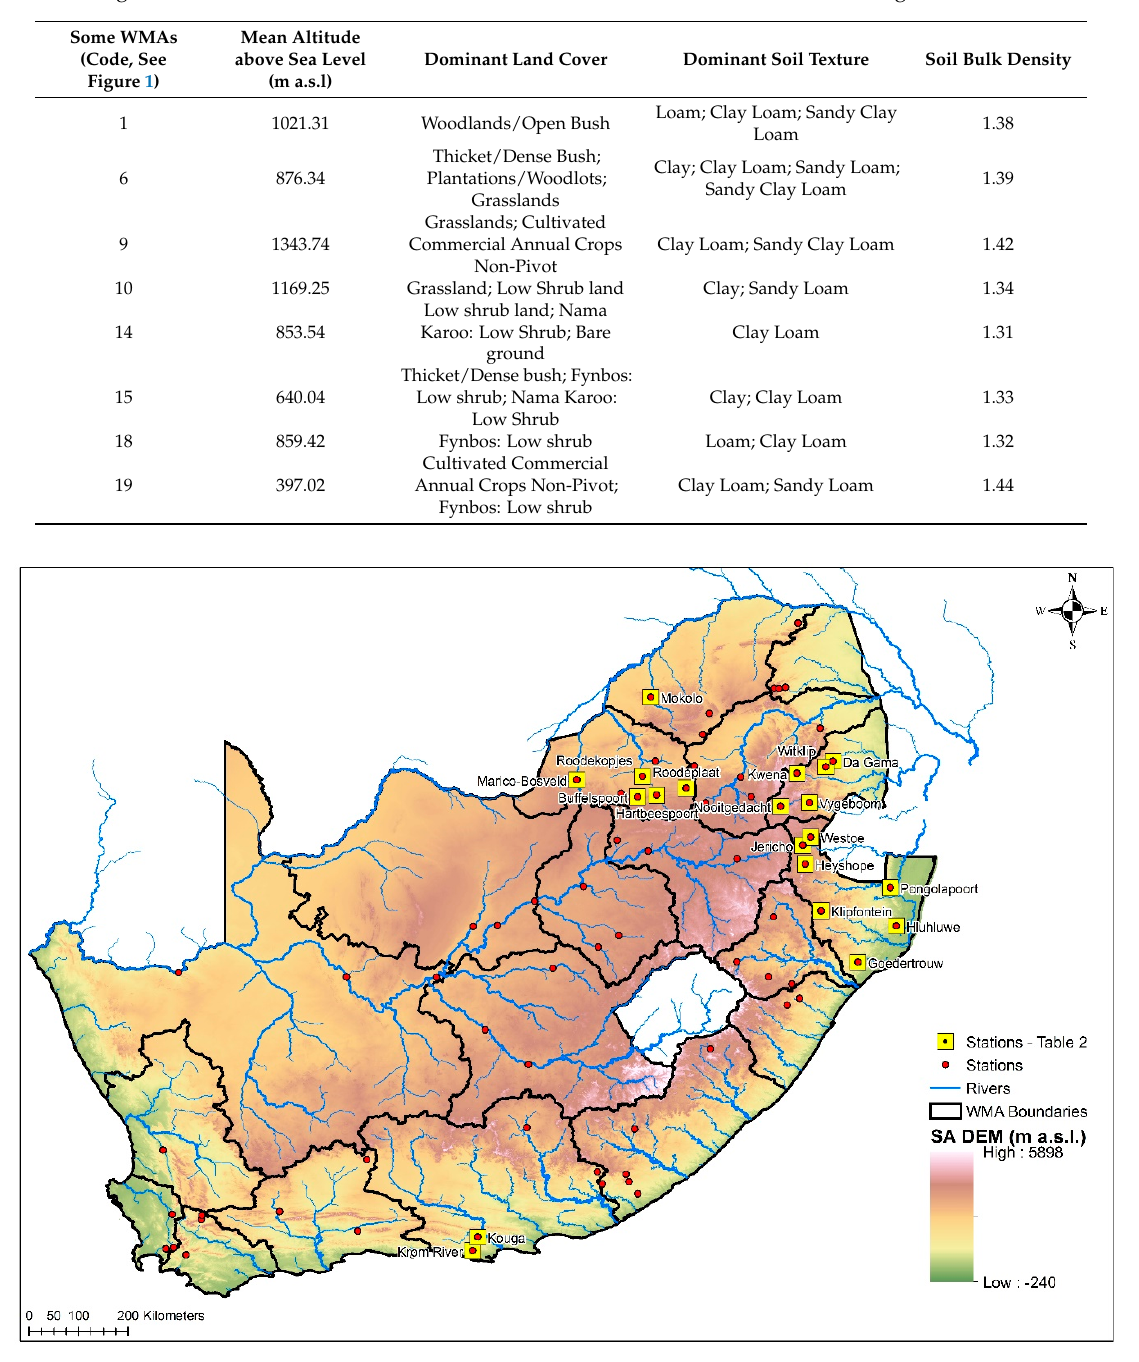
Figure 2. A map showing the location of some of the stations with rainfall, streamflow characteristics, and elevation in meters above sea level given in Table 2 (see legend).